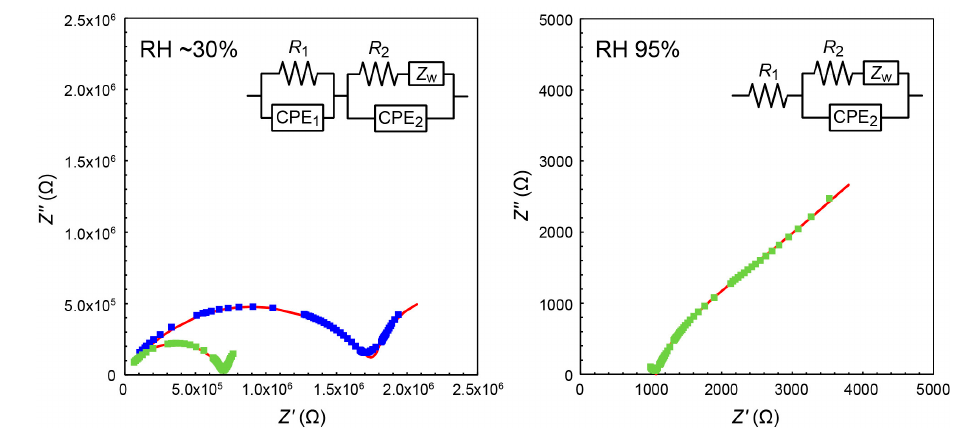
Figure 7. Nyquist plots of CP-MAImC 1 -PW 12 /MAImC 8 Br (1:1) hybrid copolymer at 298 K (blue) and 313 K (green) without additional humidity (RH ~30%) ( left ) and with additional humidity of RH 95% ( right ). The simulated spectra (red line) are based on an equivalent electronic circuit in the figure. Table 4. Estimated parameters with the equivalent circuit for CP-MAImC 1 -PW 12 /MAImC 8 Br (1:1). Circuit Parameter